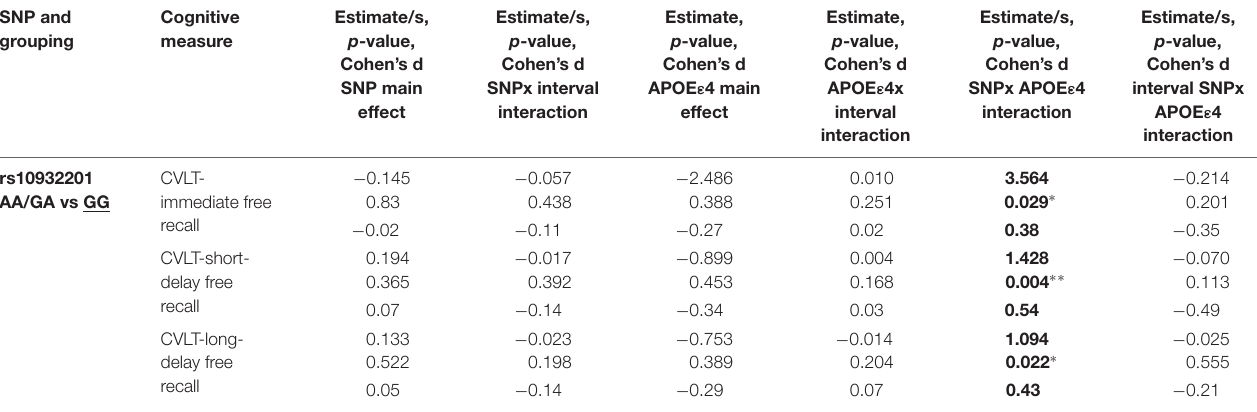
TABLE 3 | Interactions between CREB1 genotype and APOE ε 4 status significantly influence episodic memory controlling for baseline age, sex, and education. SNP and